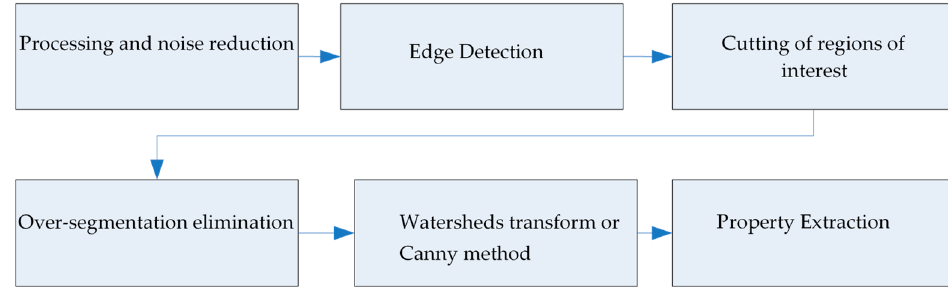
Figure 1. General segmentation process.